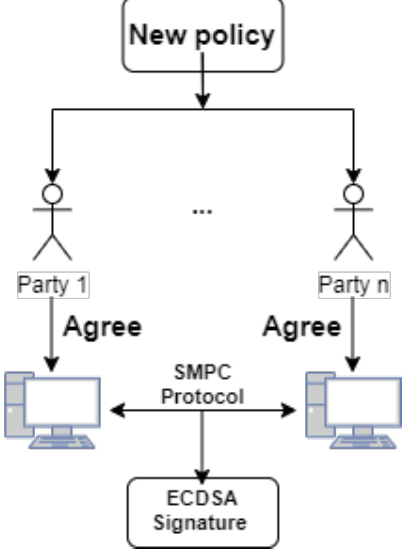
Figure 2. Multi-party computation signing flow of policies.